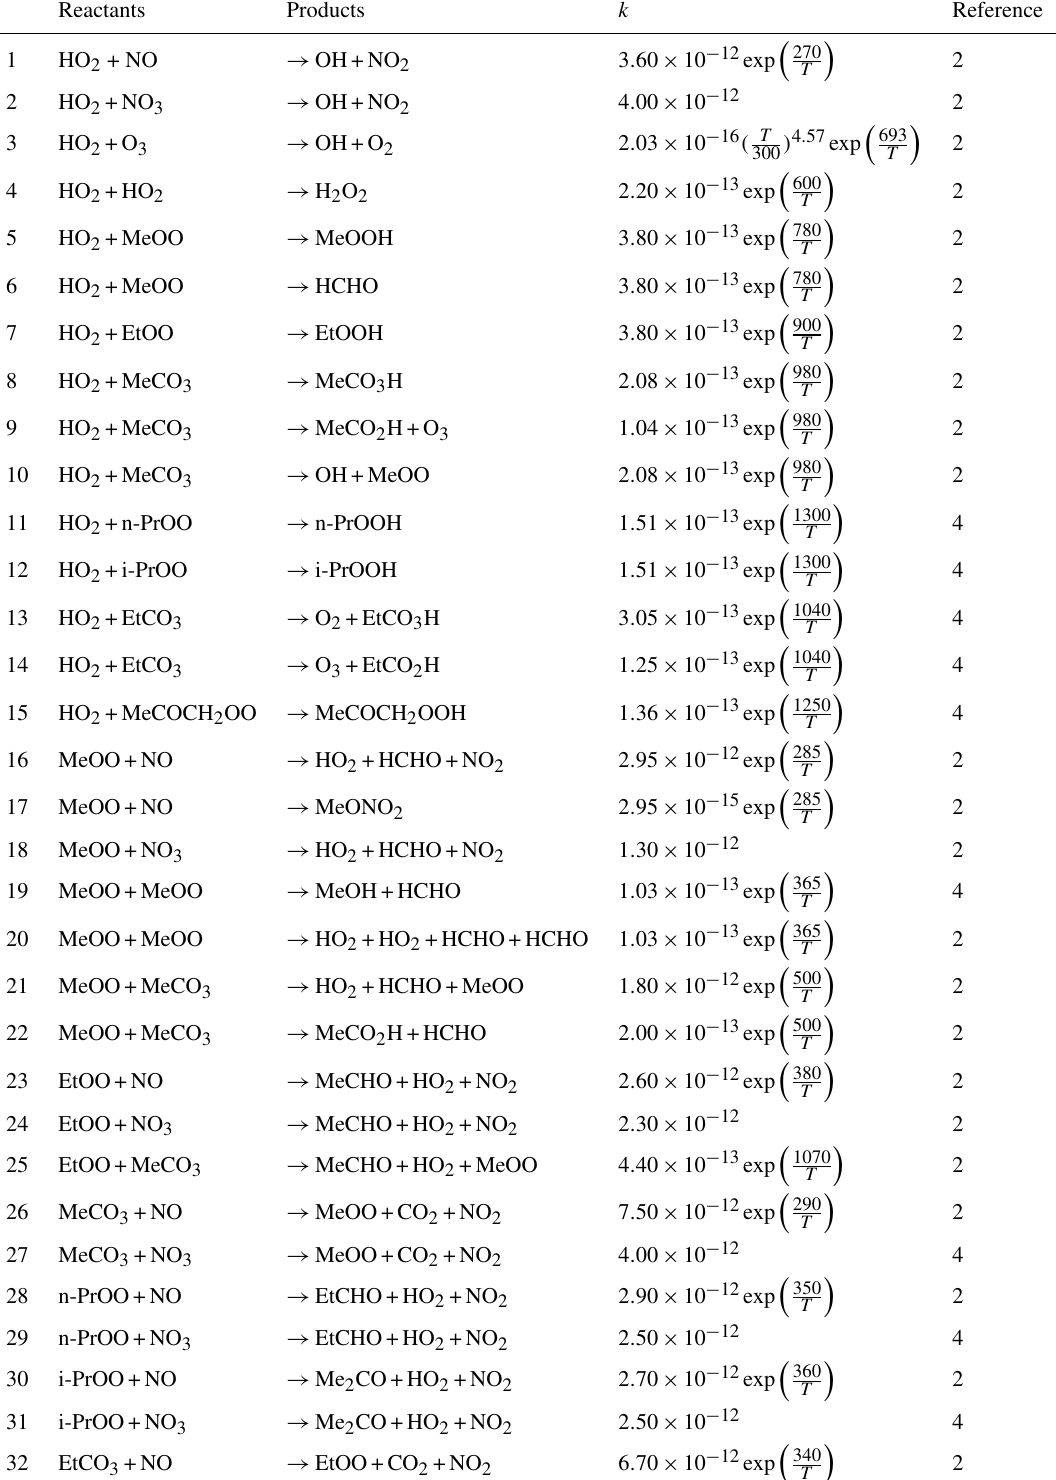
Table 3. TOMCAT gas-phase bimolecular reactions. T is the model grid-box temperature in kelvin. Reaction rate references 1: Atkinson et al. (2004a), 2: Atkinson et al. (2005), 3: Atkinson et al. (2006a), 4: MCM (2004), 5: Tyndall et al. (2001), 6: Ravishankara et al. (2002), 7: Pöschl et al. (2000), 8: Kinnison et al. (2007), 9: Folberth et al.